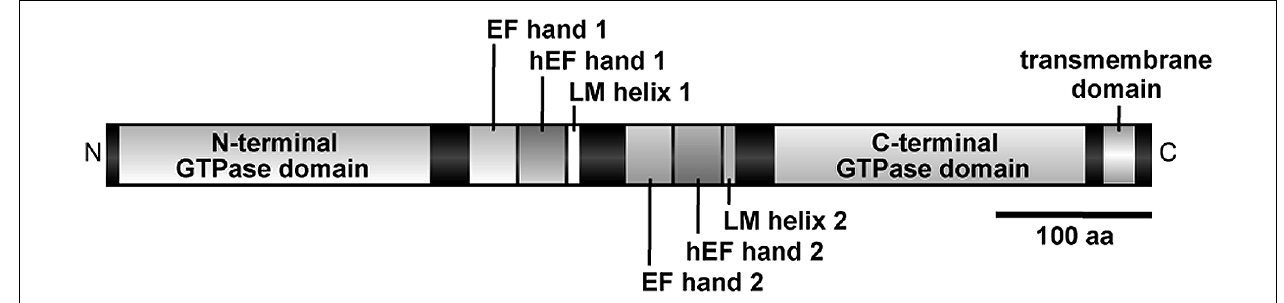
FIGURE 1 | Molecular structure of the Miro GTPase. Schematic representation of the molecular structure of Miro according to Klosowiak etal. (2013). Domain names are described in the text.The bar indicates a length corresponding to 100 amino acid residues.